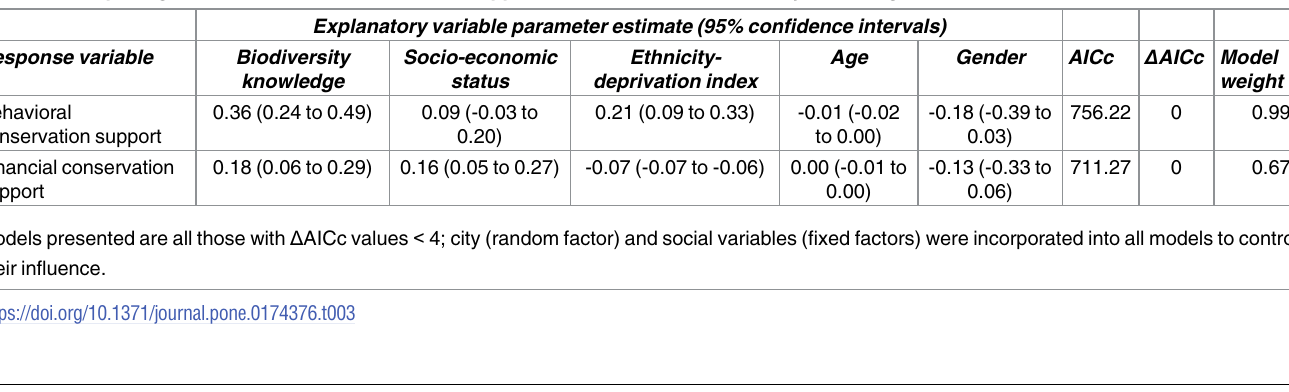
Table 3. Multiple regression models of conservation support as a function of biodiversity